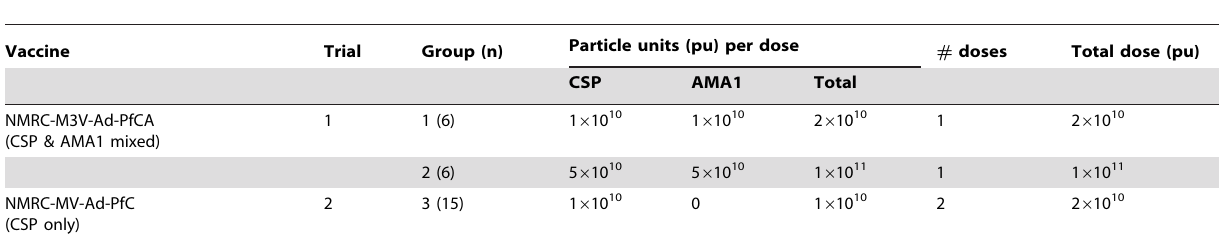
Table 1. Vaccine constructs, doses, and times of immunization.